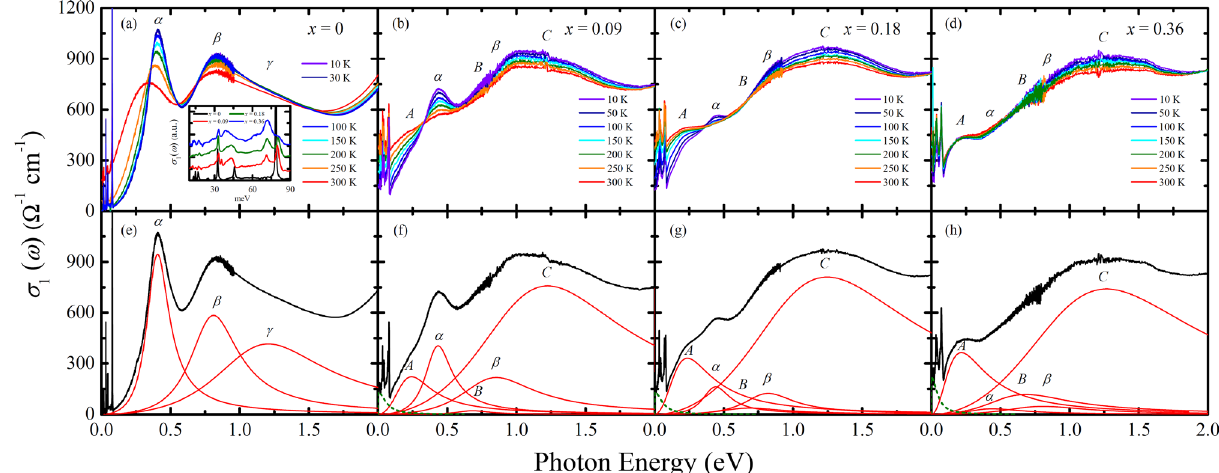
Figure 1. Temperature dependent optical conductivity spectra σ 1 ( ω ) of Sr 3 (Ir 1- x Mn x ) 2 O 7 for ( a ) x = 0, ( b ) x = 0.09, ( c ) x = 0.18, ( d ) x = 0.36 from T = 10 to 300 K. The inset of ( a ) displays the σ 1 ( ω ) below 100 meV. The baseline of each spectrum is shifted for clarity. Fitting results of the Drude-Lorentz oscillator model (dashed lines: Drude oscillators, solid lines: Lorentz oscillators) for ( e ) x = 0, ( f ) x = 0.09, ( g ) x = 0.18, ( h ) x = 0.36 at T = 10